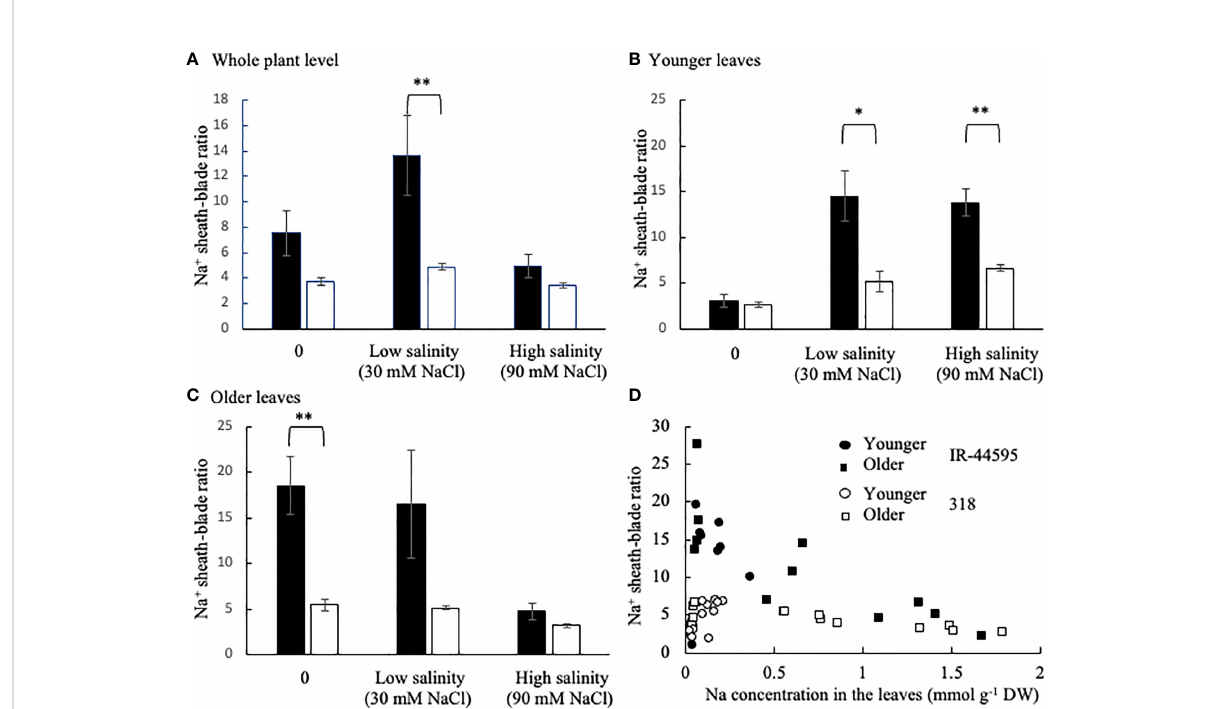
FIGURE 4 Na + sheath-blade ratio at the whole plant level and in the younger and older leaves of IR-44595 and 318 plants. Plants were grown for 19 days in soil culture then treated with low (30 mM) and high (90 mM) concentration of NaCl for further 3 weeks. (A) Na + sheath-blade ratio at the whole plant level, (B) in younger leaves, (C) in older leaves, are shown. The relationship between Na + concentration in the leaves including leaf blades and leaf sheaths and the Na + sheath-blade ratio is also shown (D) . Data are mean ± the standard error (n = 4). * and ** indicate signi fi cant difference at P<0.05 and 0.1 between IR-44595 and 318 under each treatment (Student ’ s t